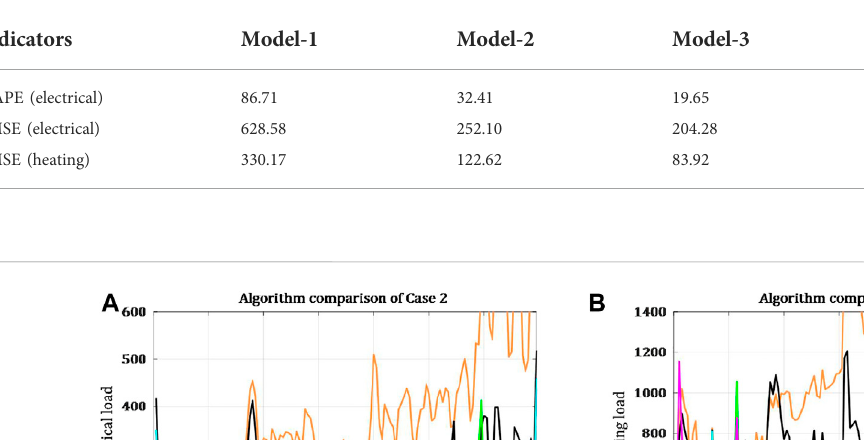
TABLE 1 Indicator results of the different models for the heating period in Case 1.The exact meaning of Model 1-5 has been given at the beginning of Section 4.